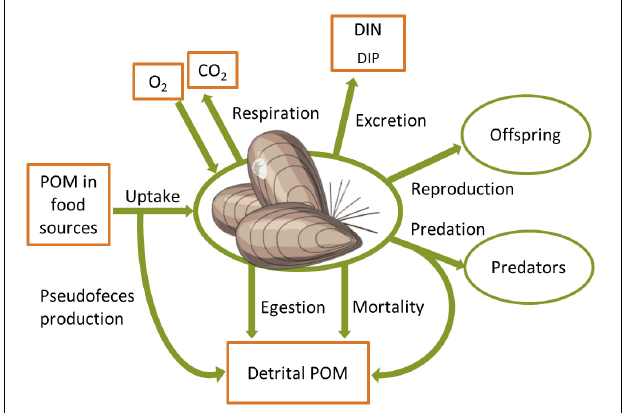
FIGURE 2 | Biomass source and sink processes of a typical benthic animal with links to C, N, P and O cycles. POM, particulate organic matter; DIN, DIP, dissolved inorganic N and P,